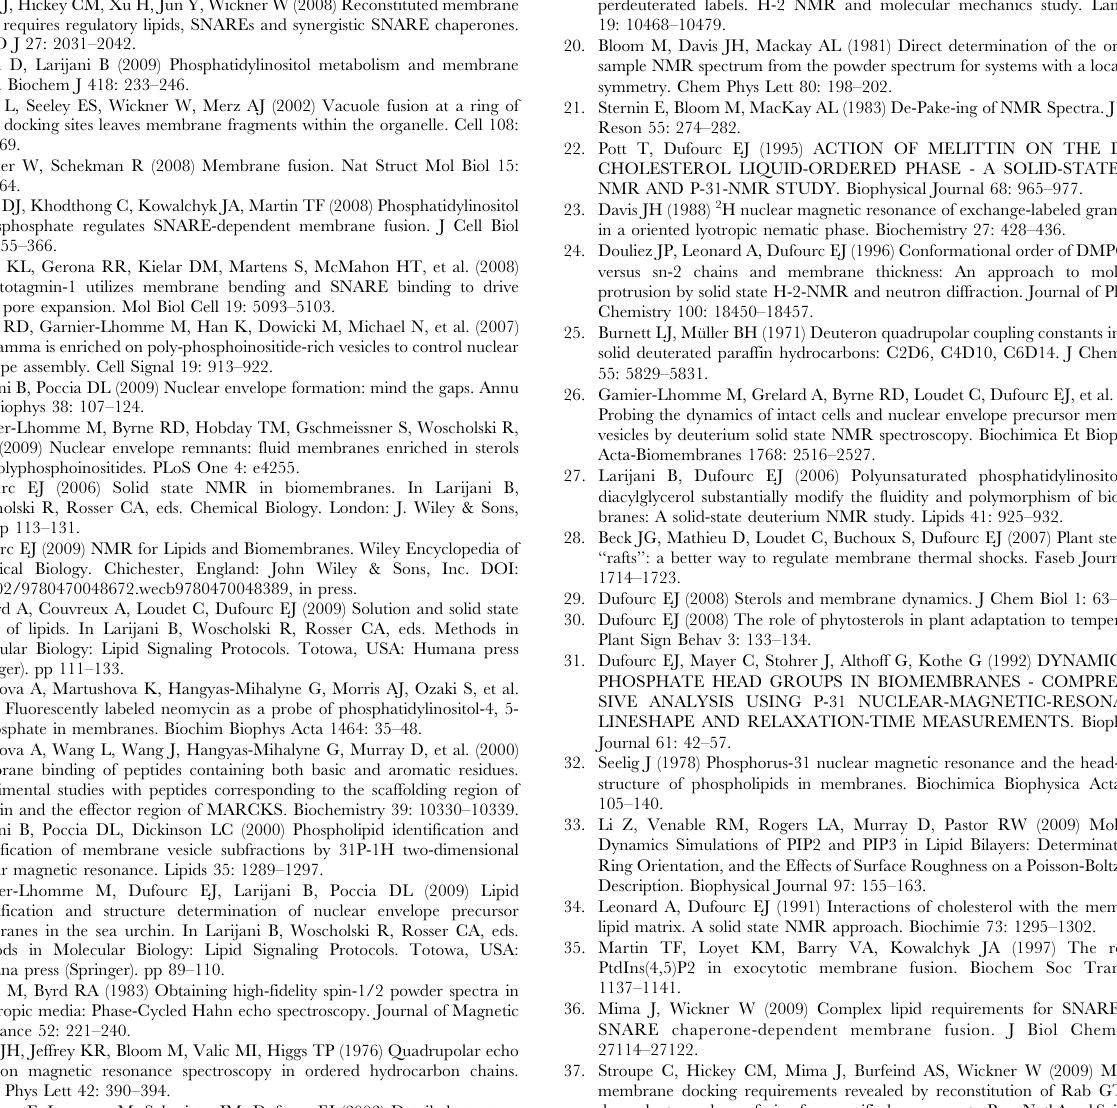
added to the graphs. Other parameters are in main